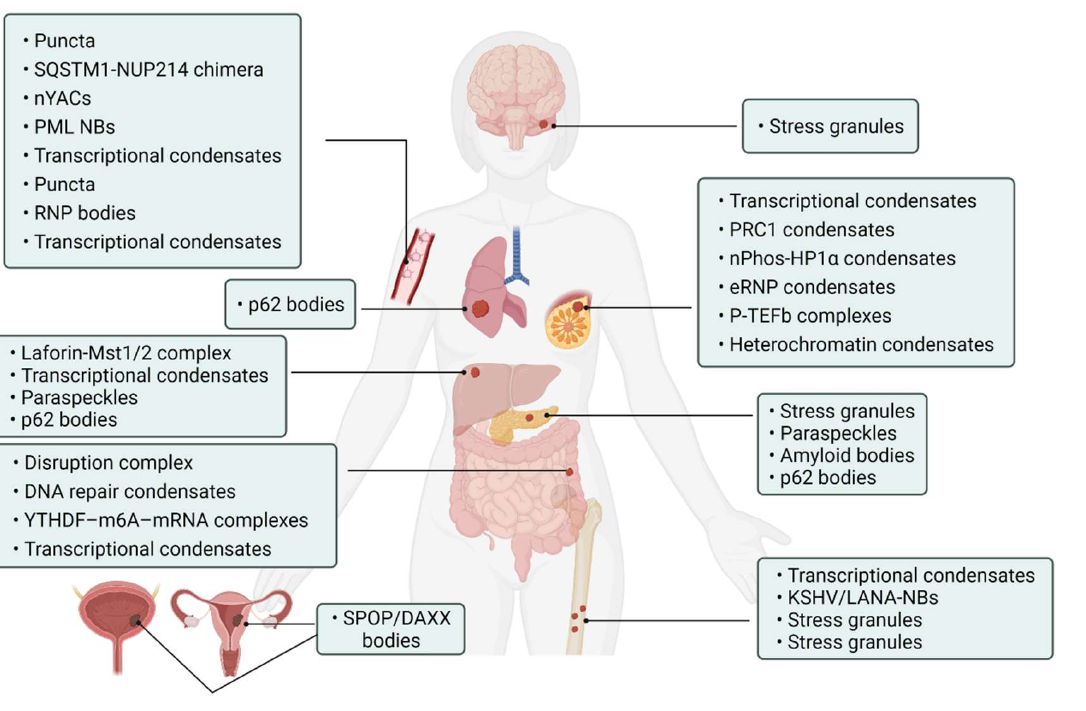
Figure 4. Cancer-related condensates in human cancers. Distribution of various types of cancer and related condensates in the human body. Created with BioRender.com.